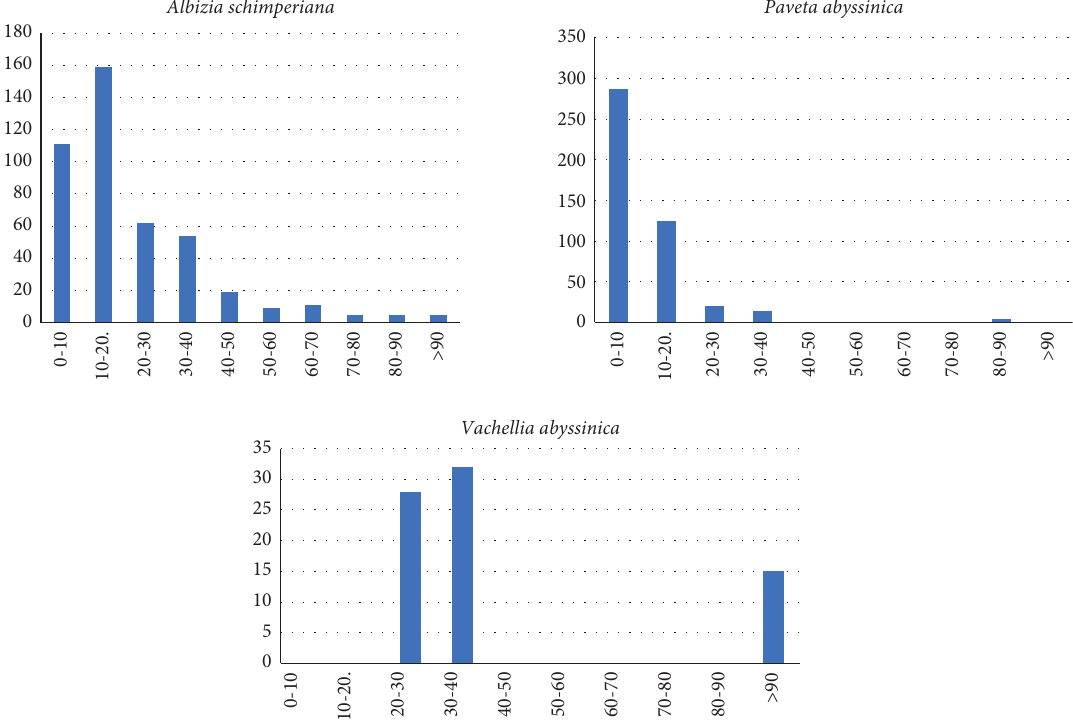
Figure 7: DBH class distribution of selected dominant plant species (where X -axis indicates DBH class and Y -axis indicates plant